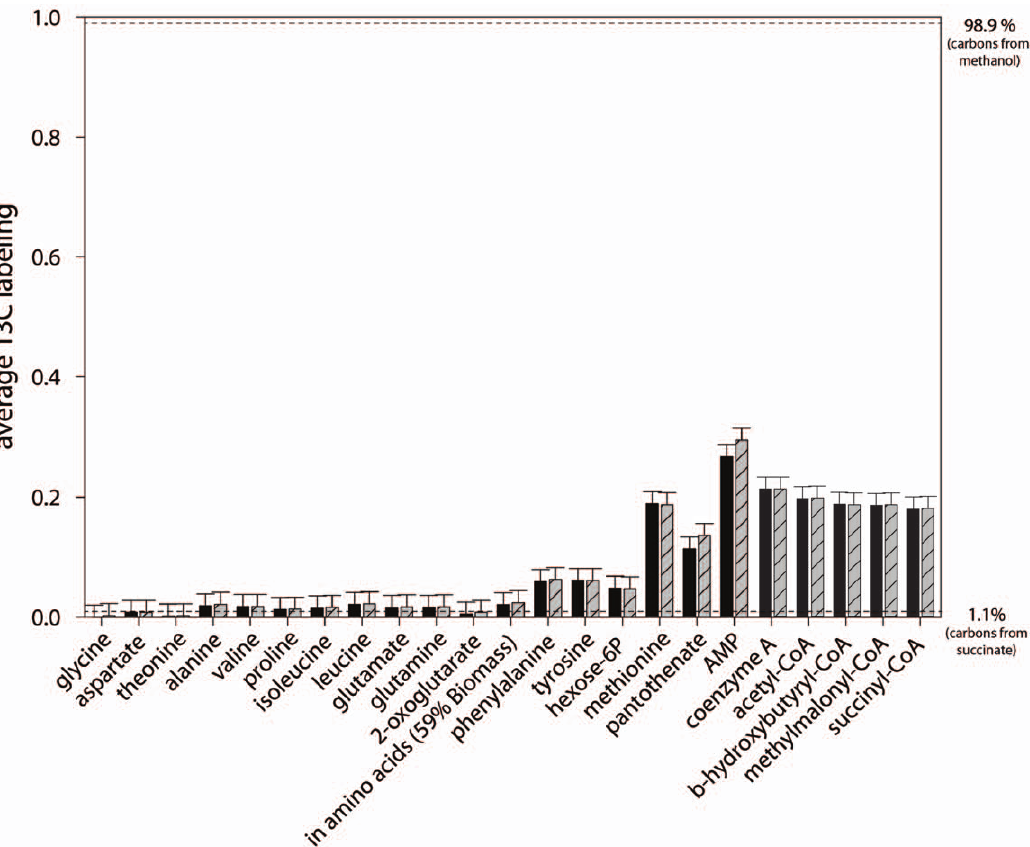
Figure 2. Average 13 C labeling in intra-cellular metabolites measured by LC-MS during the growth of M.extorquens AM1 upon co- consumption with 13 C ( . 99%) methanol and natural abundance (1.1% 13 C) succinate. Metabolite quenching, extraction and measurements were performed specifically for each class of metabolite, i.e., amino acids, polar compounds, and coenzyme A thioesters, as described in the materials and methods. Average 13 C labeling. (black): Sample collected during mid-co-consumption phase (Sampling time 1 in Figure 1), (gray hatched): sample collected at the end of the co-consumption phase (Sampling time 2 in Figure 1). doi:10.1371/journal.pone.0048271.g002 PLOS ONE |